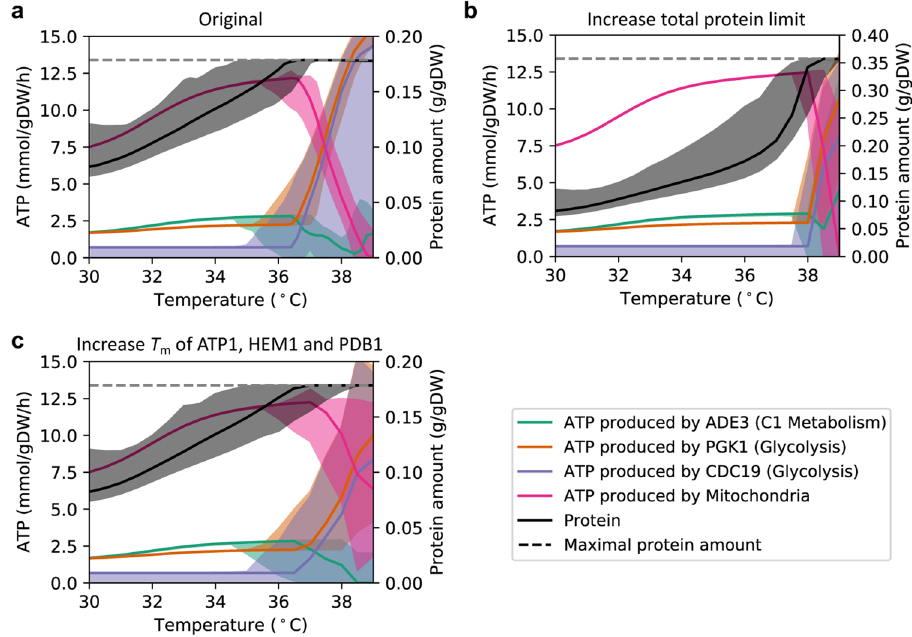
Fig. 4 Metabolic shifts are explained by temperature-induced proteome constraints. The ATP production in the cytoplasm and the total protein amount required at different temperatures were simulated using Posterior etcGEMs with chemostat culture settings with a dilution rate of 0.1 h − 1 ( “ Methods ” ). Simulation results from a the original Posterior models, b the original Posterior models with doubled total protein constraint, c the original Posterior models with increased T m of ATP1, HEM1, and PDB1 (to 50 °C) and are shown. Lines indicate median values and shaded areas indicate the region between the 5th and 95th percentile ( n = 100). Source data are provided as a Source Data fi